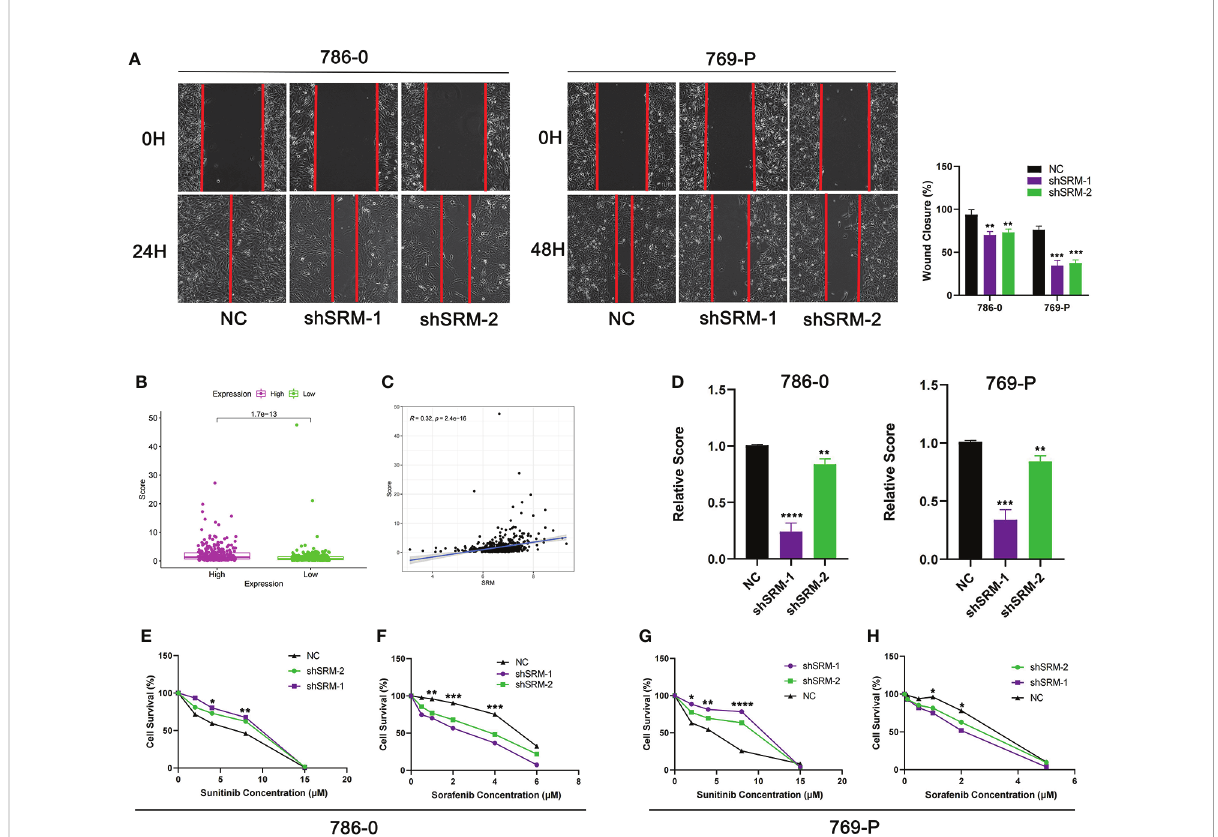
FIGURE 10 Validation of treatment response in vitro . (A) Scratch assay was used to detect the effect of SRM on the migration ability of 786-0 and 769-P. (B) Score difference between high and low SRM expression groups. (C) Correlation analysis between score and SRM expression. (D) Differences in scores between shSRM and negative control cell lines. (E – F) Effect of knockdown of SRM on 786-0 cell survival after treatment with sunitinib and sorafenib. (G – H) Effect of knockdown of SRM on 769-P cell survival after treatment with sunitinib and sorafenib. *p < 0.05, **p < 0.01, ***p < 0.001, ****p <